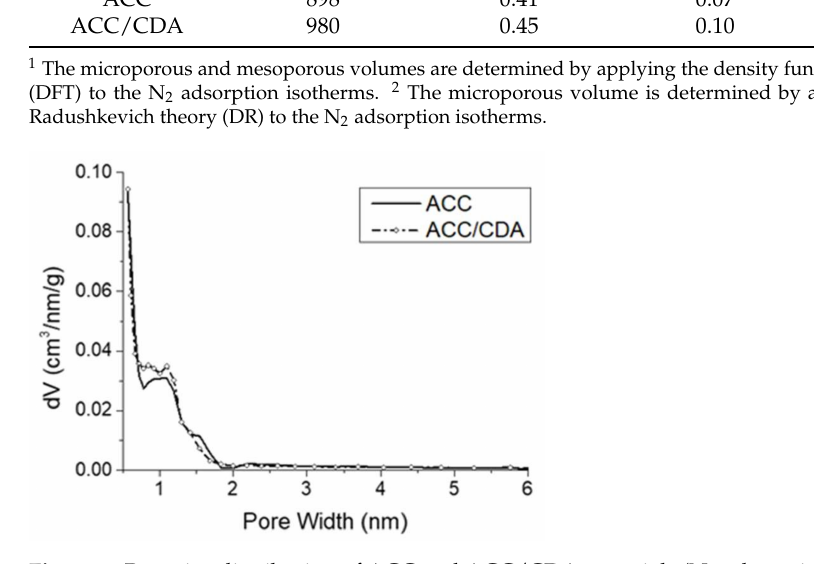
Figure 2. Pore size distribution of ACC and ACC/CDA materials (N 2 adsorption at 77